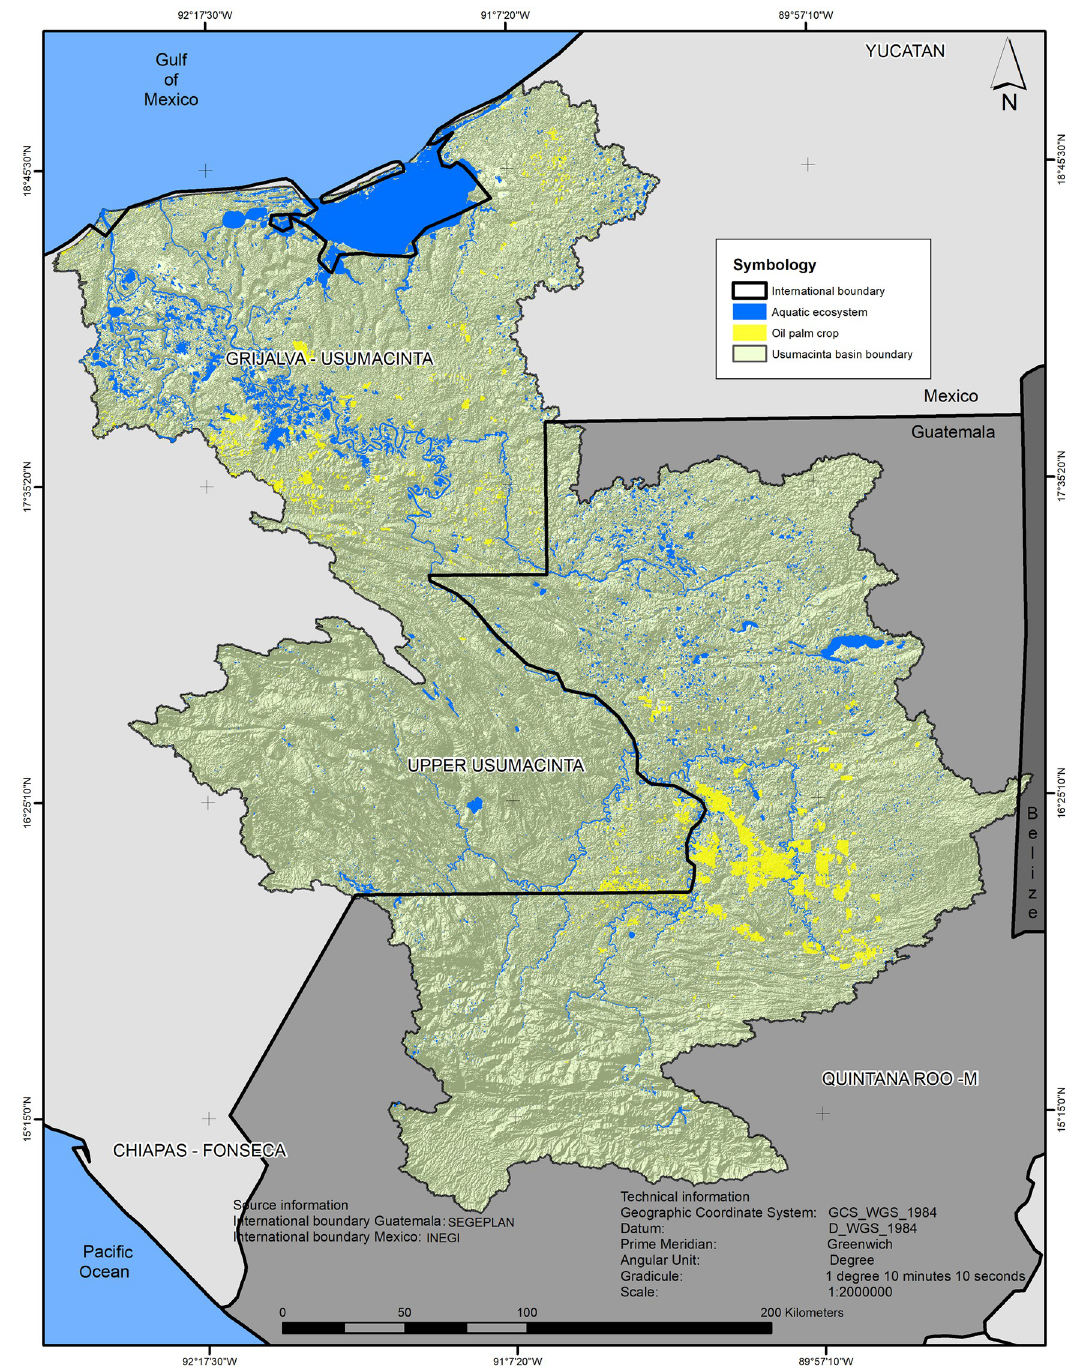
Fig 1. Study area. Note: For a better representation, in this map we include the polygons of the aquatic system used in the Land use/ land cover (LULC) analysis as well as the drainage network (lines). (Data source: Digital Elevation Model courtesy of the U.S. Geological Survey and drainage network for Mexico and Guatemala courtesy of INEGI and SEGEPLAN, respectively).